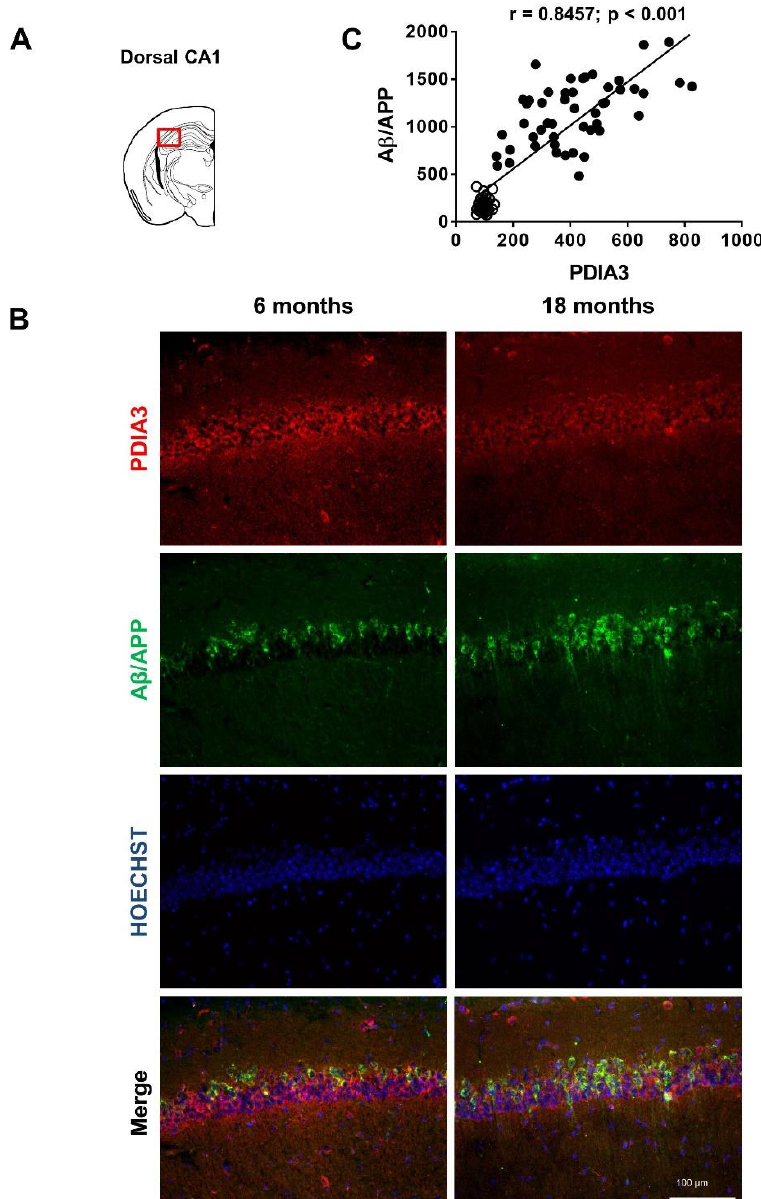
Figure 4. A β /APP-PDIA3 protein levels revealed in the dorsal CA1 region of hippocampus of 3 × Tg-AD mice: ( A ) The brain diagram illustrates the site where the representative microphotographs of the dorsal CA1 region of hippocampus were taken; ( B ) Representative microphotographs of A β /APP-PDIA3 double-fluorescent immunostaining (green and red, respectively) performed on brain slices of dorsal CA1 region of hippocampus collected from 6- and 18-month-old 3 × Tg-AD mice. Hoechst (blue) was used as fluorescent counterstain. Original magnification: 20 × ; scale bar was set at 100 µ m; ( C ) Scatterplot of A β /APP vs. PDIA3 protein levels in the dorsal CA1 region of hippocampus of 6- and 18-month-old 3 × Tg-AD mice. A β /APP and PDIA3 levels refers to the results obtained by the semiquantitative analyses of the fluorescence signals as optical densities within the same cell and under the same exposure conditions. Open circles: 6-month-old 3 × Tg-AD mice; closed circles: 18-month-old 3 × Tg-AD mice. Data are expressed as mean optical densities ± SEM. Statistical significance threshold was set at p < 0.05.